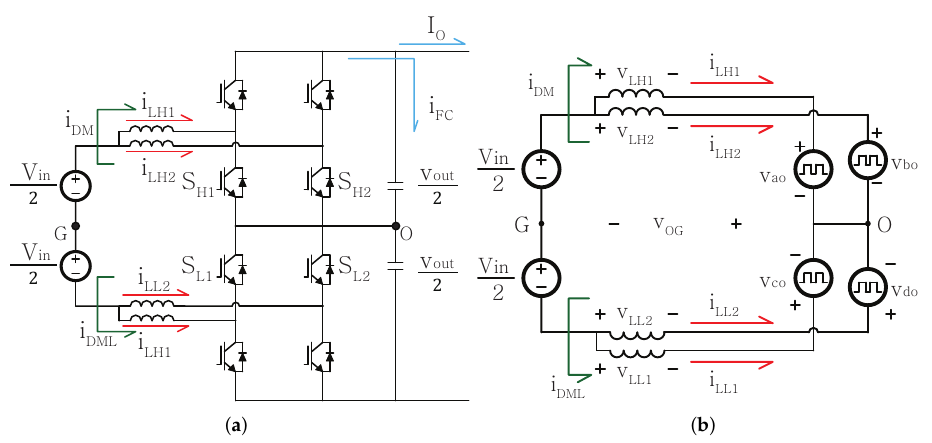
Figure 4. ( a ) Circuit diagram of a two-phase parallel TLBC; ( b ) equivalent circuit diagram of a TLBC with interleaving